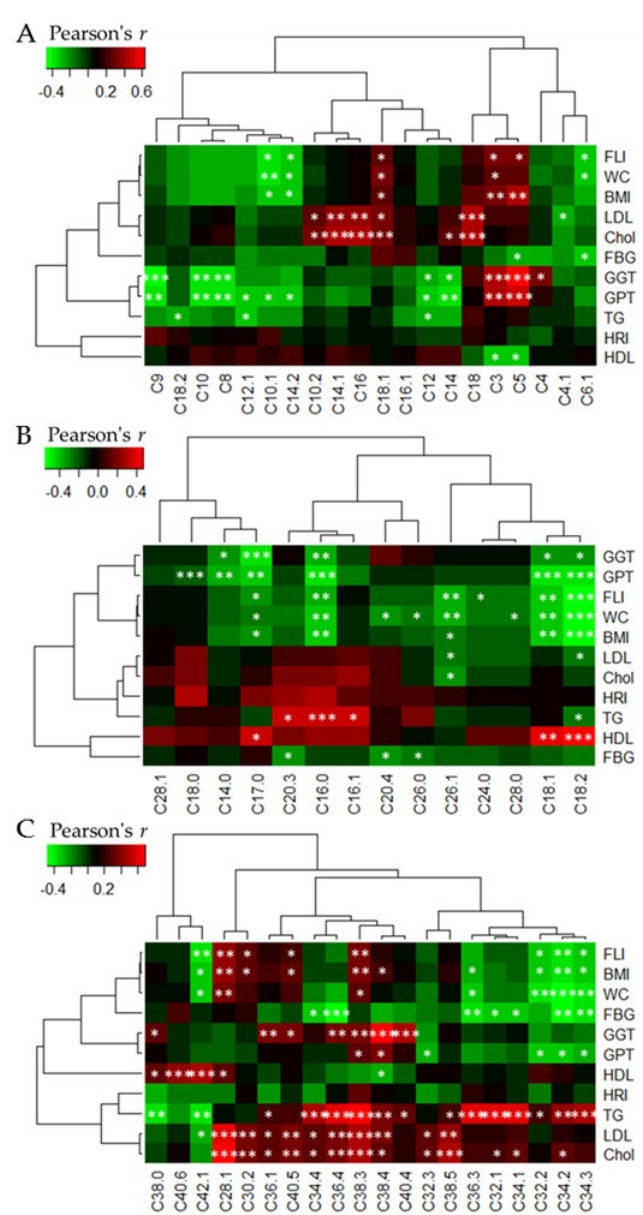
Figure 6. Correlation heatmap (Pearson correlation) of metabolites and clinical parameters. ( A ) Acylcarnitines, ( B ) lysophosphatidylcholines, ( C ) diacyl-phosphatidylcholine. Green colored fields show negative correlation coefficients ( r ) and red colored field positive ones. The dendrograms show the hierarchical clustering of metabolite classes and clinical parameters. Abbreviations: BMI, body mass index; Chol, total blood cholesterol; FBG, fasting blood glucose; FLI, fatty liver index; GGT, gamma-glutamyl-transpeptidase; GPT, glutamate-pyruvate-transaminase; HDL, high density lipoprotein; HRI, hepatorenal index; LDL, low density lipoprotein; TG, triglycerides; WC, waist circumference.